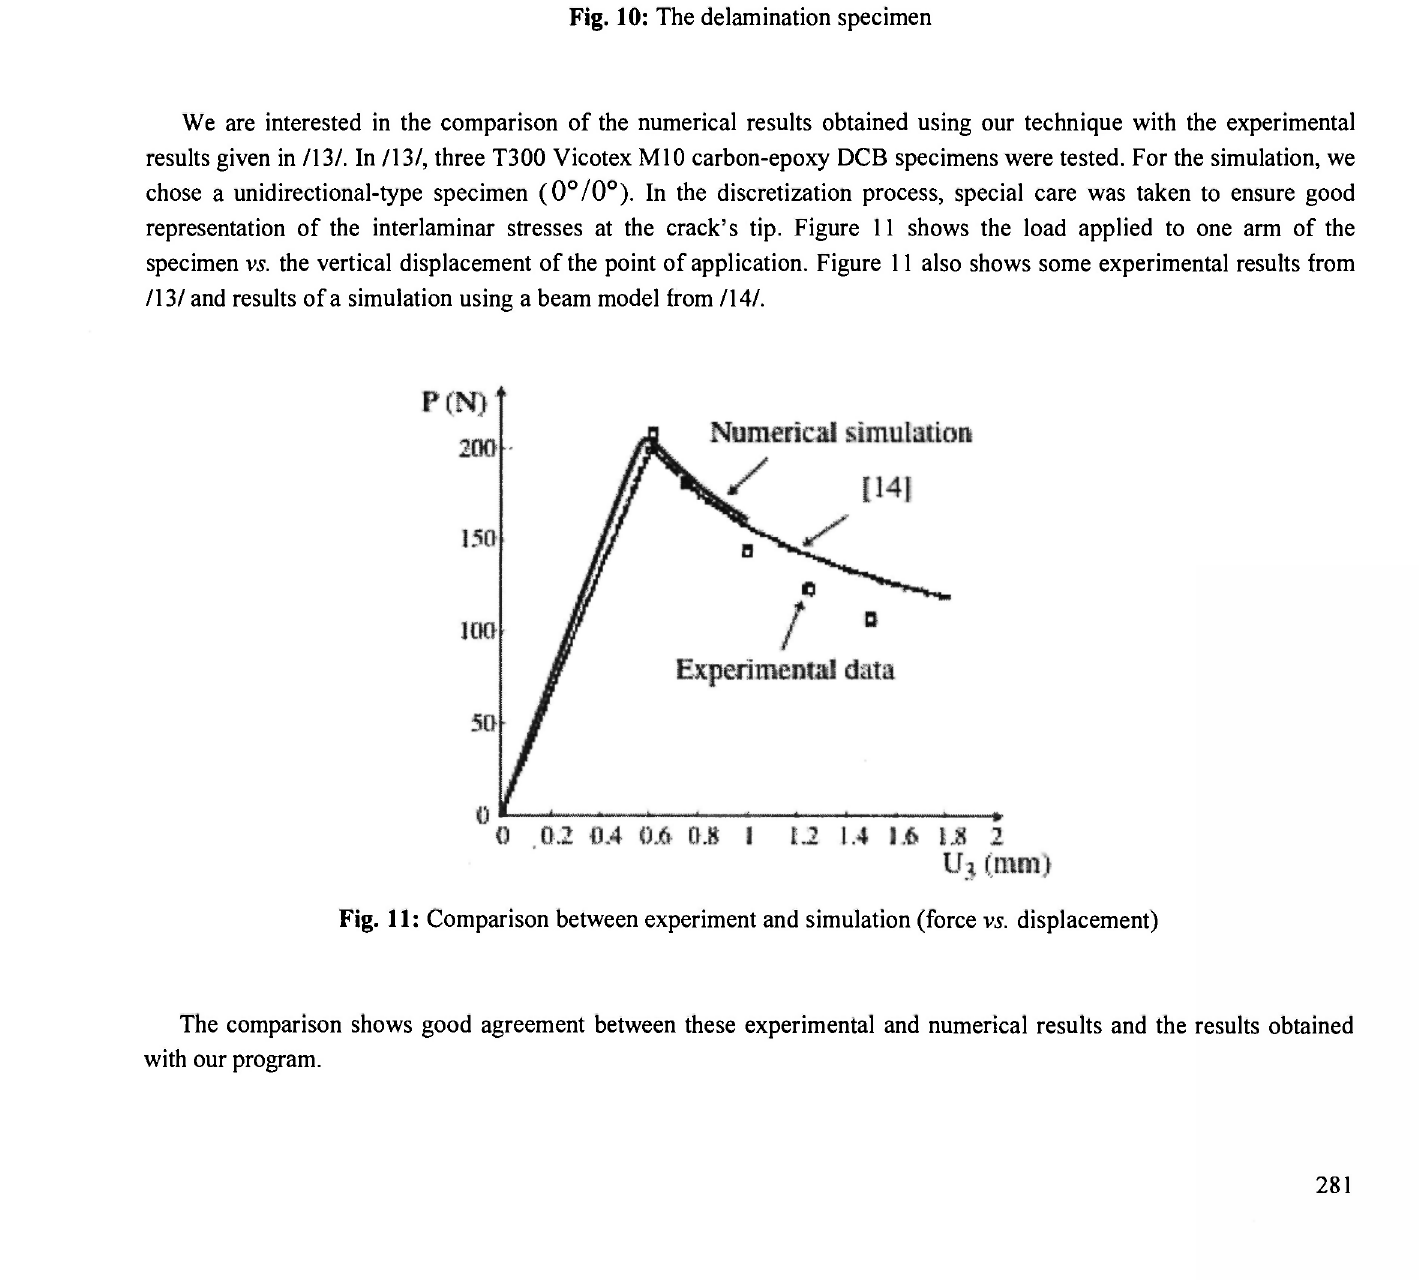
Fig. 10: The delamination specimen